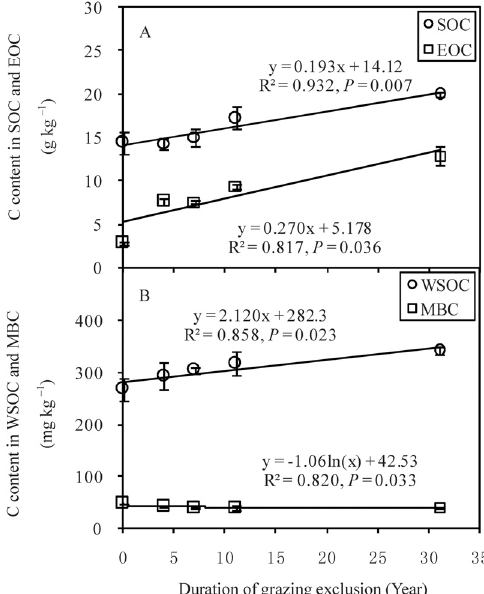
Fig 2. Changes in soil organic carbon (SOC), easily oxidizable organic carbon (EOC) (A), water- soluble organic carbon (WSOC), and microbial biomass carbon (MBC) (B) with grazing-exclusion duration in the Inner Mongolian